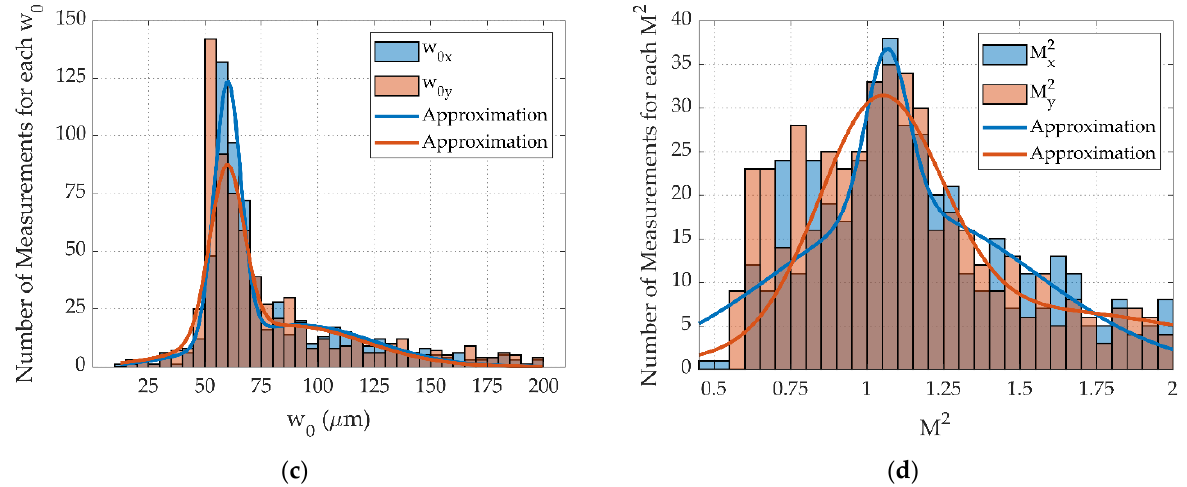
Figure 5. Numerical calculations of ( a ) Radius of curvature R ( z 2 ) depending on the longitudinal coordinate; ( b ) Rayleigh length z R ; ( c ) Waist radius w 0 ; ( d ) Parameter M 2